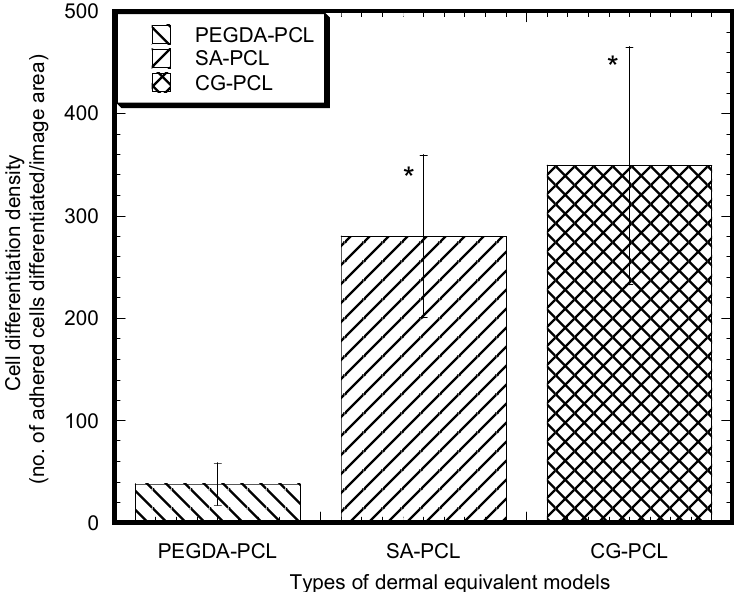
Figure 8. Mean cell differentiation value ( ± standard error) for the PEGDA-PCL, SA-PCL, and CG1-PCL groups. Data are presented with n = 8 for both samples. Note: * p < 0.1 (compared to PEGDA- PCL).